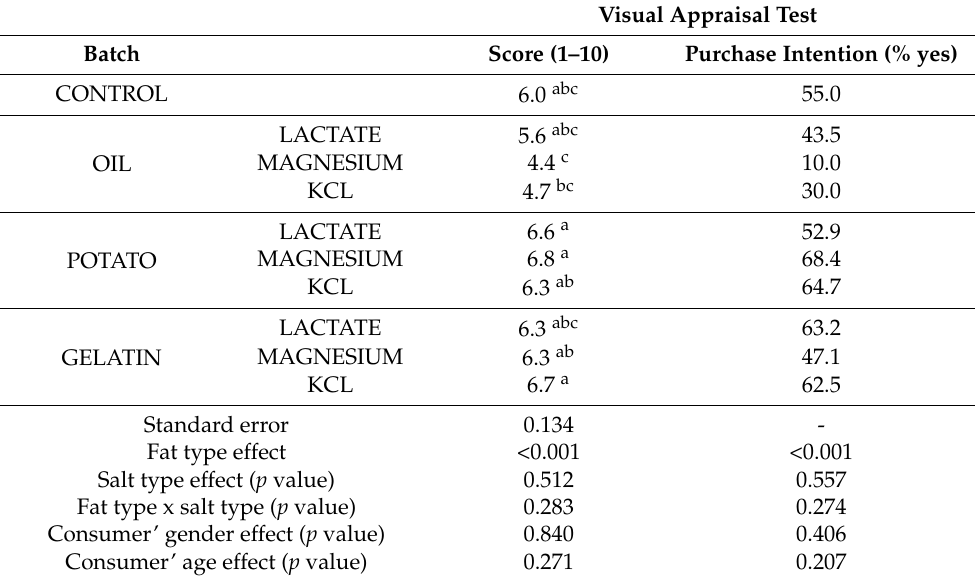
Table 5. The means and standard error for scores in a visual appraisal test and the percentages of purchase intention based on the visual appraisal for 10 experimental batches of dry-fermented sausages. p values for batch effect and for consumer gender and age